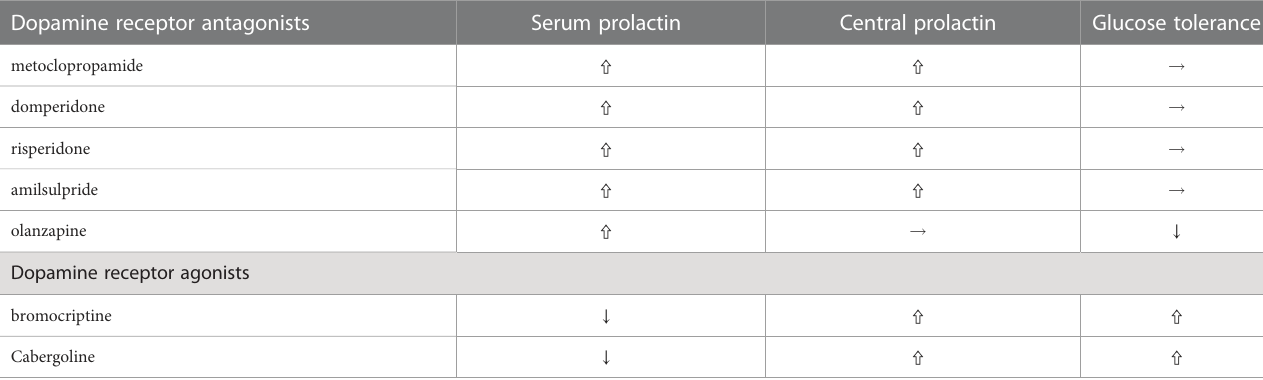
Cabergoline Solid arrows, stimulates; Dashed arrows,